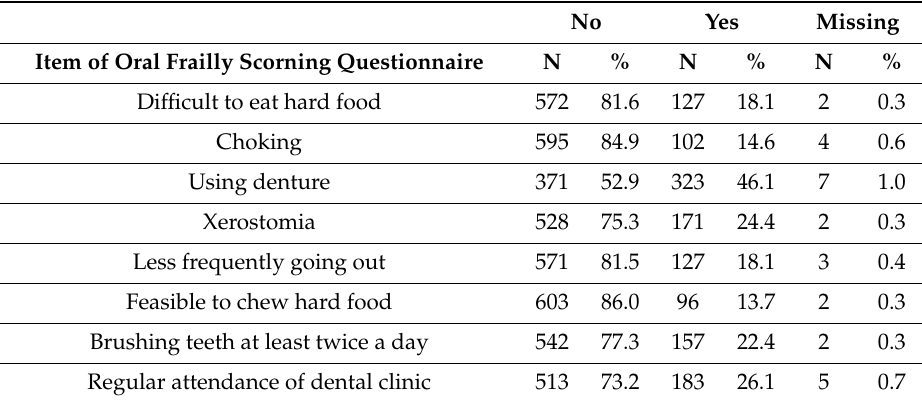
Table 2. Frequency of the items of oral frailly scorning